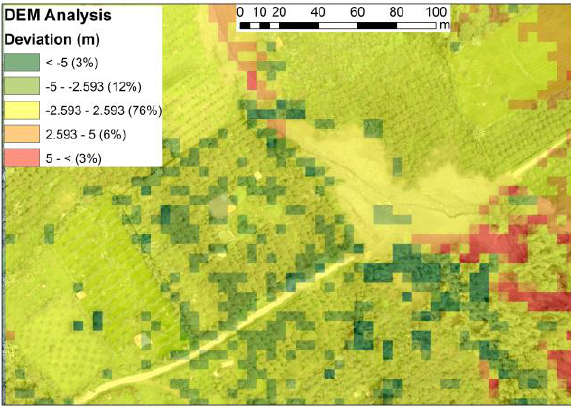
Figure 4. This area can be presumably predicted as the relevant mud flow covered area in post disaster